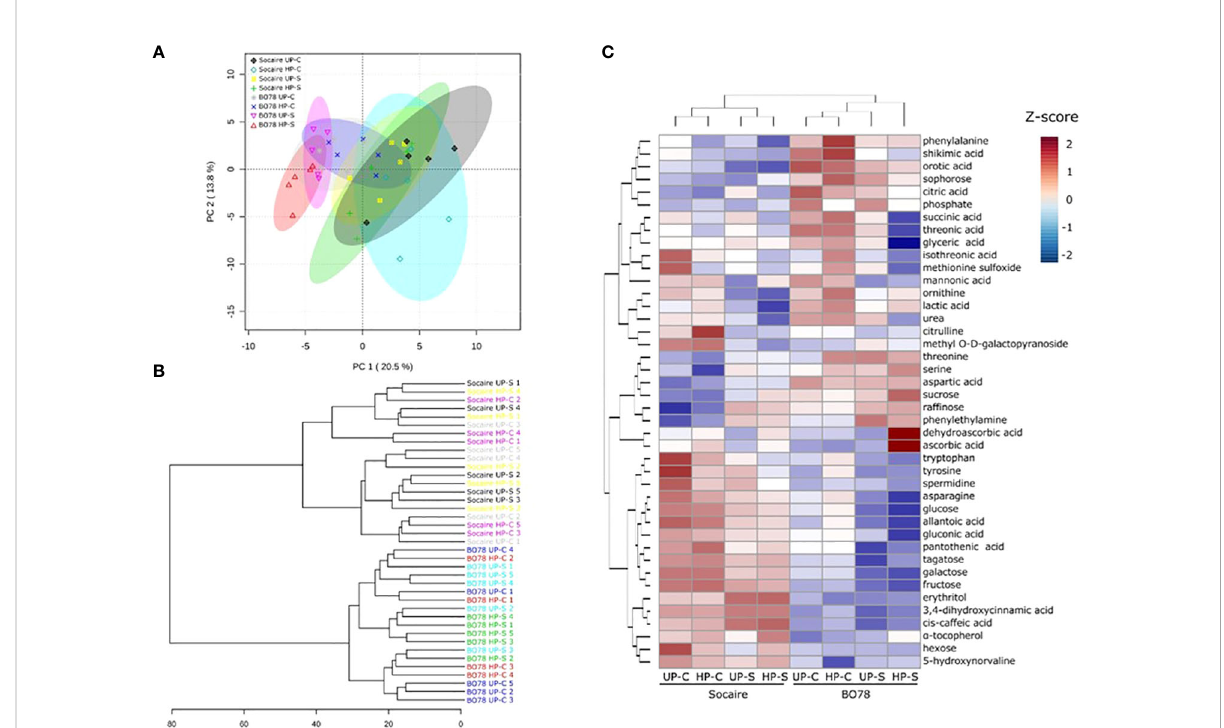
FIGURE 6 Principal component analysis (PCA) (A) , hierarchical clustering dendrogram (B) , and heatmap for metabolome pro fi ling data (C) . The PCA, hierarchical clustering dendrogram, and clustered heatmap show the most changing metabolites (42 metabolites) under the different conditions (UP-C, HP-C, UP-S, and HP-S) in both ecotypes. Heatmap scale bar shows standardized metabolite values color-coded from low (blue) to high (red).